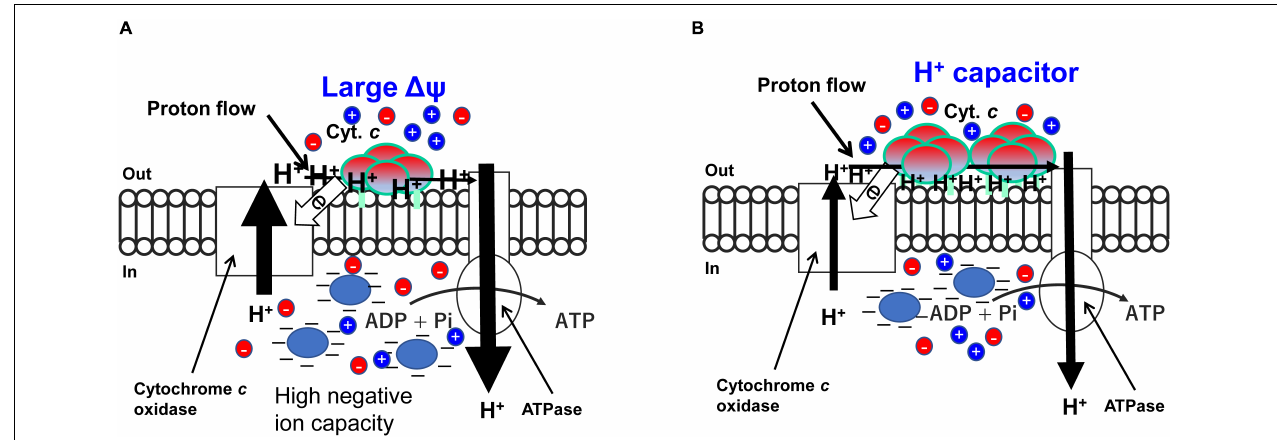
FIGURE 4 | High efficiency of H + located on the outer surface of the membrane based mainly on the (cid:49)(cid:57) and hydrogen bond network produced by the membrane bound cytochrome c segment in high (A) and low (B) aeration conditions, respectively in obligately alkaliphilic Evansella clarkii . Although the rate of respiratory translocating H + is predicted to lower in high aeration (A) , efficiency per H + for production of ATP is higher in the high-aeration conditions compared with that of in low-aeration conditions (B) . This difference is attributed to the larger electrical potential ( (cid:49) ψ ) in high-aeration conditions than that in low-aeration conditions. The mechanism of the occurrence of the high (cid:49) ψ may be attributed to a Donnan effect produced by membrane impermeable negatively charged substances (Blue ellipse) and heterogenous membrane permeable ions (red and blue circles). The high (cid:49) ψ across the membrane may be a heavy burden for H + translocation by the respiratory chain. However, the translocated protons may have a large potential for ATP production. The membrane bound cytochrome c content is higher in low-aeration conditions than in high-aeration conditions. The specific segment near the N-terminal sequence [Asn (N) 21 -Asn (N) 43 ; Asn (N) 4 -Asn (N) 26 in the processed protein base] in the membrane bound cytochrome c produces an H + -capacitor. The tetrameric structure and differences in the length of fatty acid anchors may have an important role for accumulation and transportation of H + on the outer surface of the membrane.